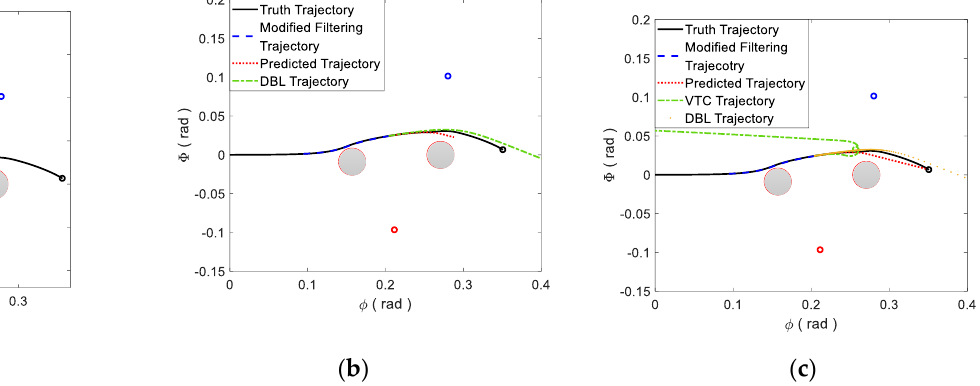
Figure 22. Comparison of lateral prediction effect among different methods: (a) is the lateral prediction effect of VTC method; (b) is the lateral prediction effect of DBL method; and (c) is the long-term lateral prediction effect.